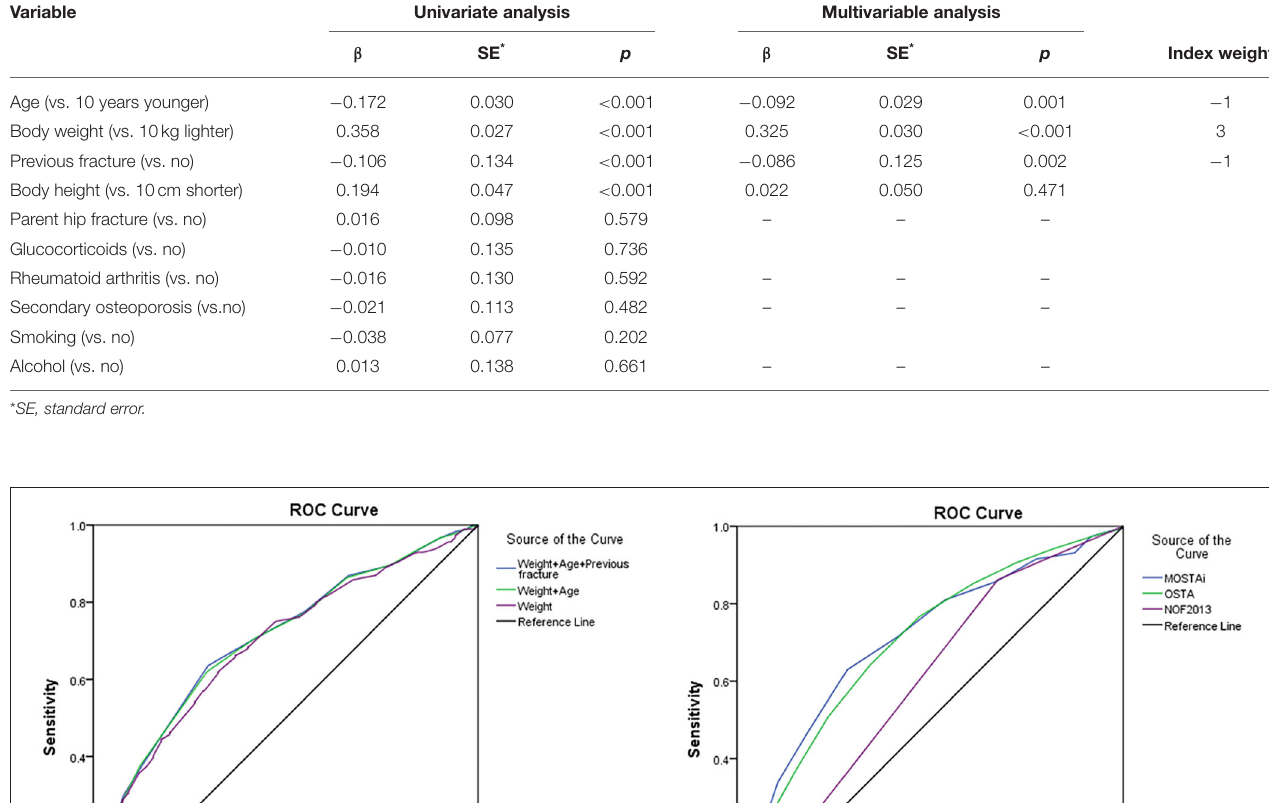
TABLE 2 | Regression coefficients for the univariate and multivariable analysis in the developmental cohort. Variable